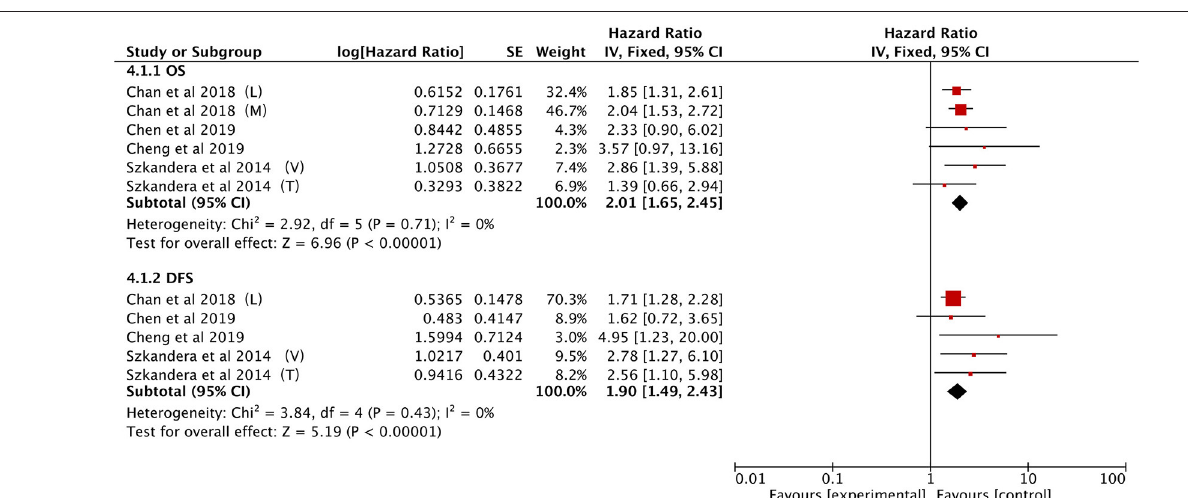
FIGURE 5 | Forest plots of the Prognostic effect of PLR for OS/DFS.